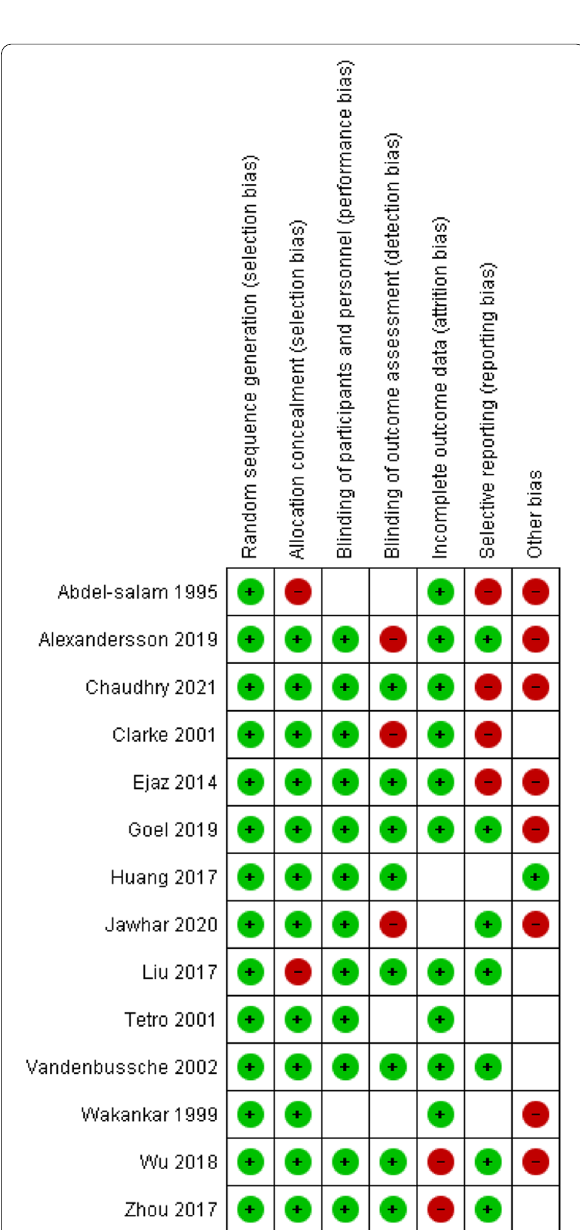
Fig. 6. The proportion of skin necrosis, blistering and